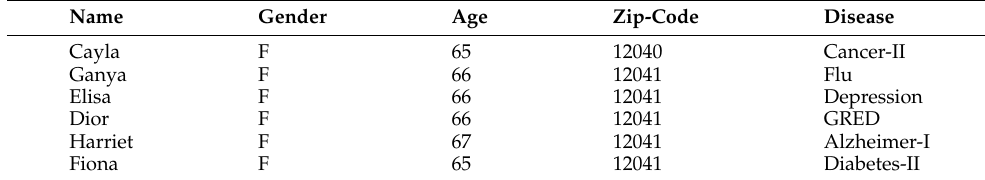
Table 1. Original microdata.